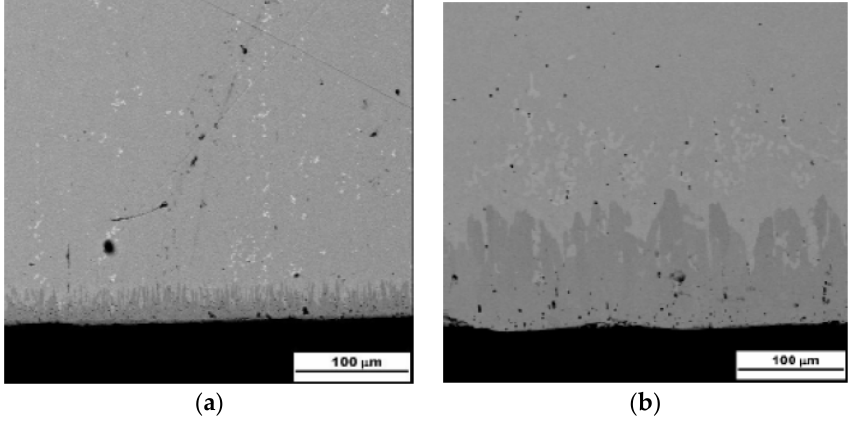
◦ C for: ( a ) 10 min and ( b ) 120